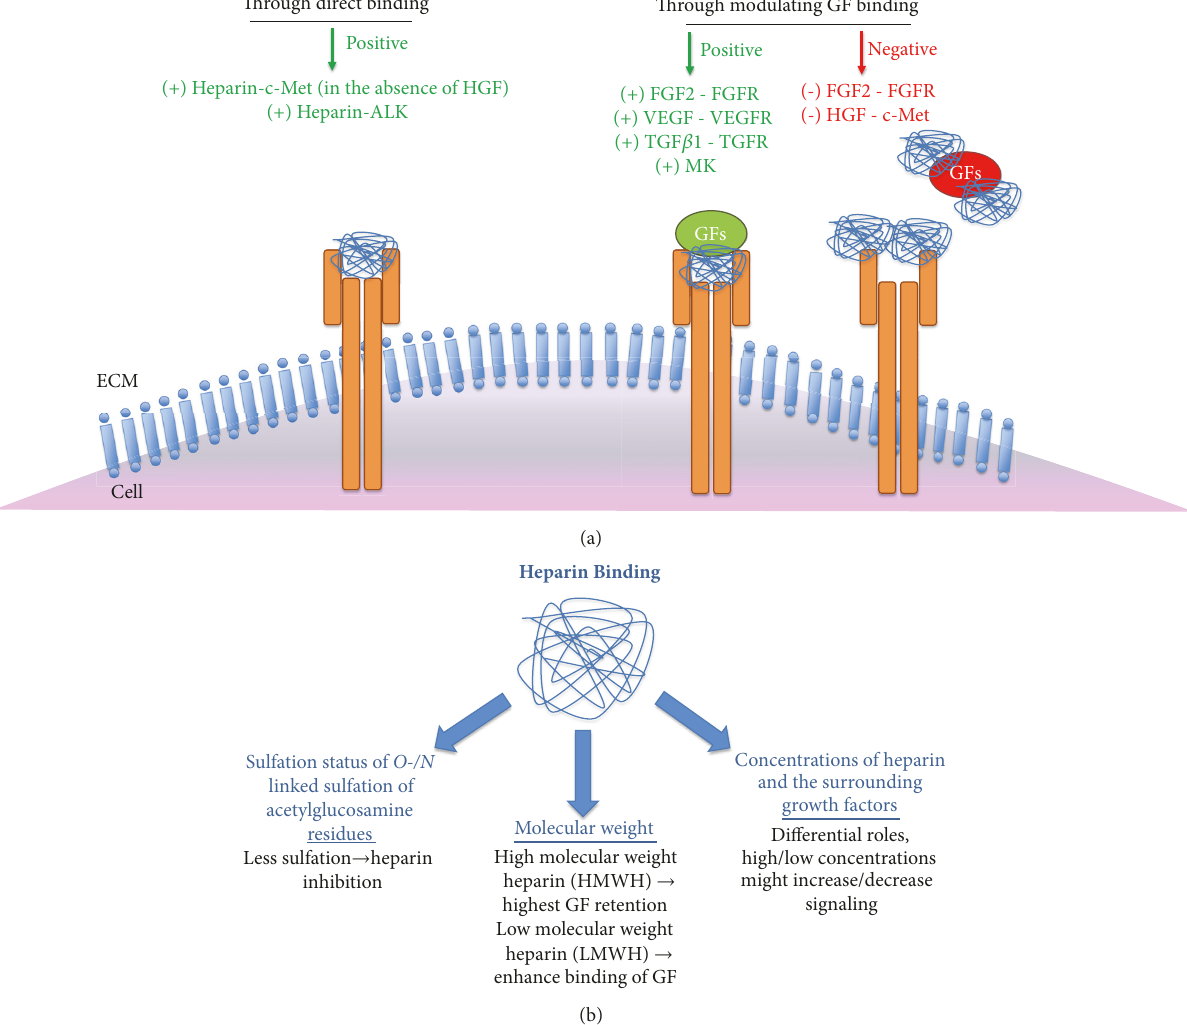
Figure 2: E ff e cts an d e ff e ctors of h e parin bin d ing . Heparin binding has context-dependent roles in Growth Factor (GF) signaling, it might directly bind to Growth Factor Receptors (GFRs) or it might modulate signaling positively or negatively through binding to both GFs and GFRs (a). Heparin binding to GFs and GFRs are affected by several factors including sulfation status, the molecular weight of heparin and the concentrations of both heparin and the GFs